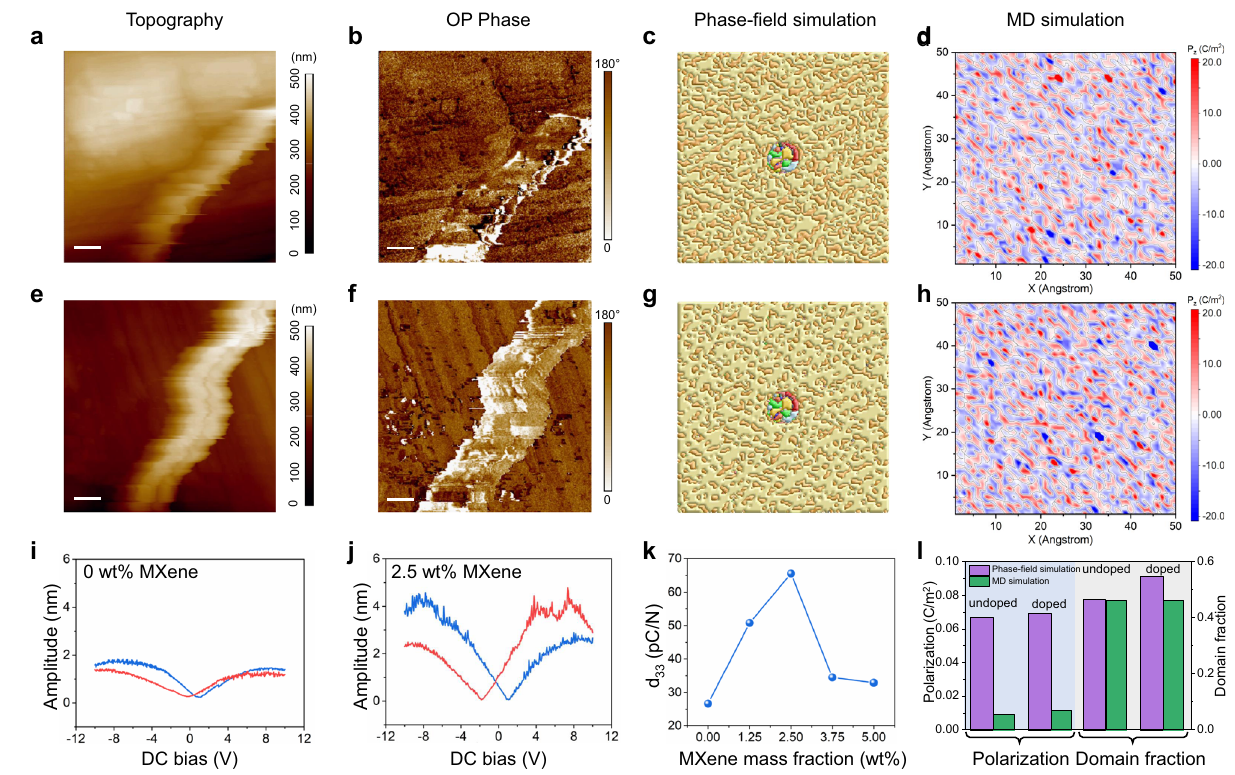
Fig. 3 | Characterization and simulations for the as-synthesized electrospun fi bers. a – d Piezoelectric force microscope (PFM) Topography ( a ), Out-of-plane (OP) PFM phase image ( b ), phase- fi eld simulation of domain structure ( c ), MD calculation of polarization ( d ) of a single undoped nano fi ber. Scale bars: 200nm. e – h PFM Topography ( e ), PFM phase image ( f ), phase- fi eld simulation of domain structure ( g ), MD calculation of polarization ( h ) of a single MPC nano fi ber. Scale